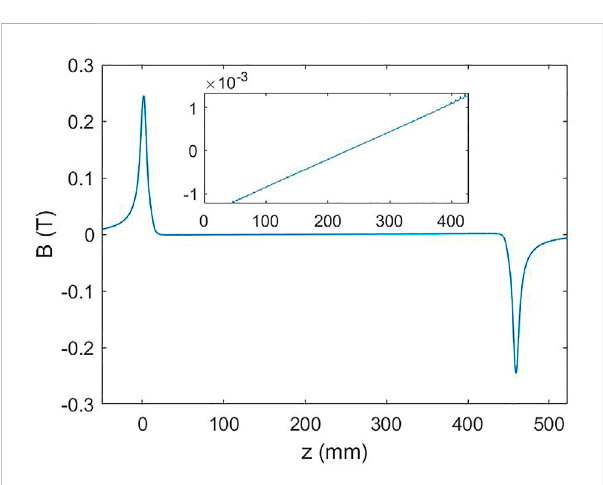
FIGURE 3 Magnetic fi eld difference caused by 10 A correction currents.